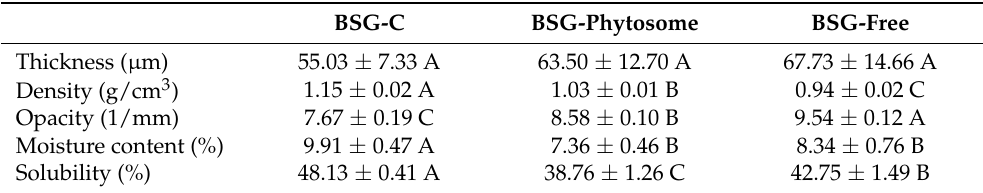
Table 3. Physical properties of control modified BSG edible film and those incorporated with tannic acid and vitamin D 3 in the encapsulated form in nanophytosome and free